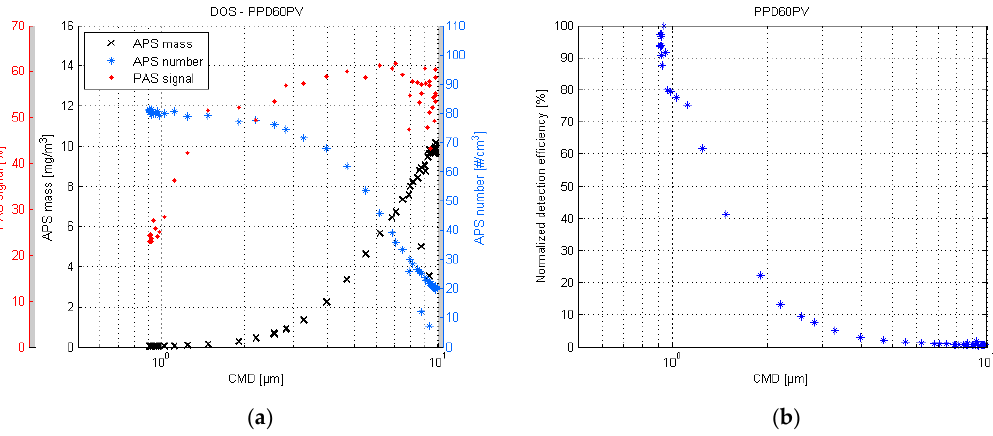
Figure 4. PPD60PV response plot of the DOS test ( a ) and the respective normalized detection efficiency scatter plot ( b ).